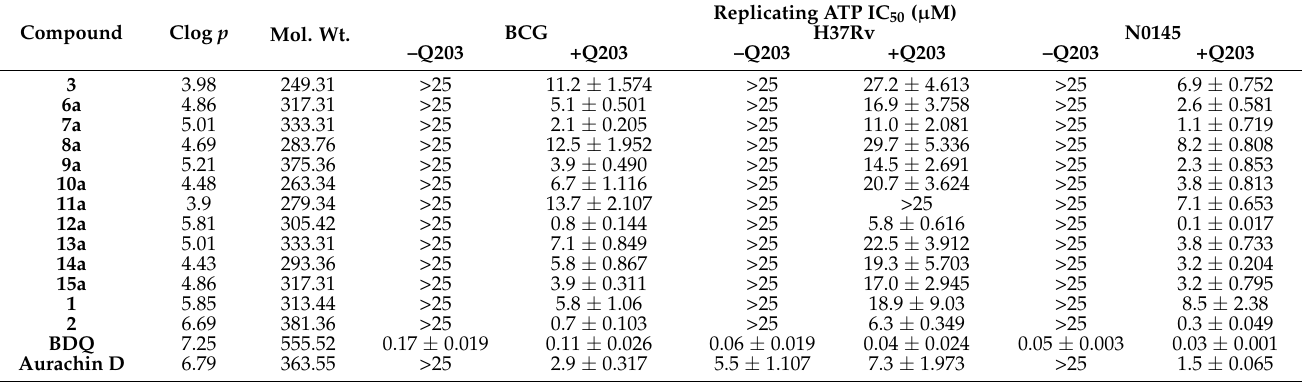
Table 1. In vitro activity of phenethyl-quinazolin-4-yl-amines ( 3 , 6a – 15a ) and control compounds bedaquiline (BDQ), ND- 11992 ( 2 ), and aurachin D against three mycobacterial strains ( M. bovis BCG, M. tuberculosis H37Rv, and M. tuberculosis N0145). Compound